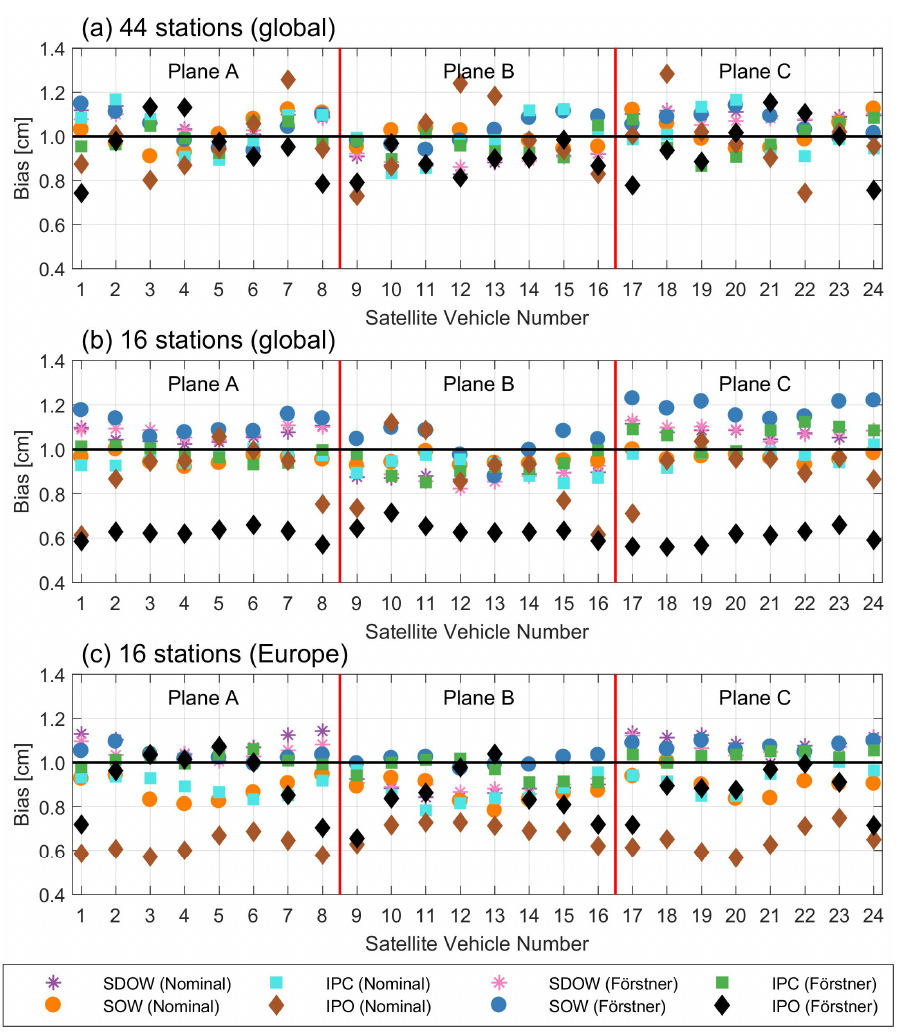
Figure 6. Mean estimated ISL range biases of each satellite (simulated value of 1.0 cm) for different ground station sets: ( a ) 44 stations (global), ( b ) 16 stations (global), and ( c ) 16 stations (Europe) under different weighting methods. Please note the scale on the vertical axis.